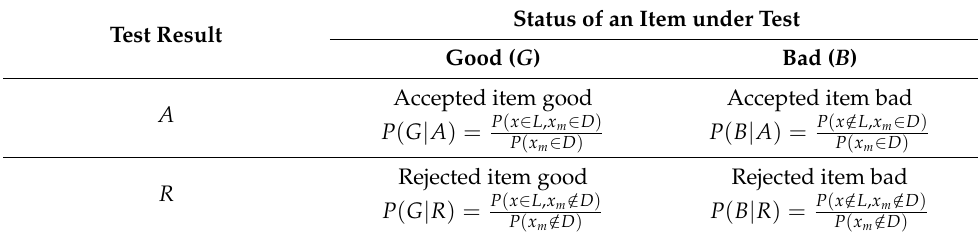
Table 3. Probabilities conditioned on the test